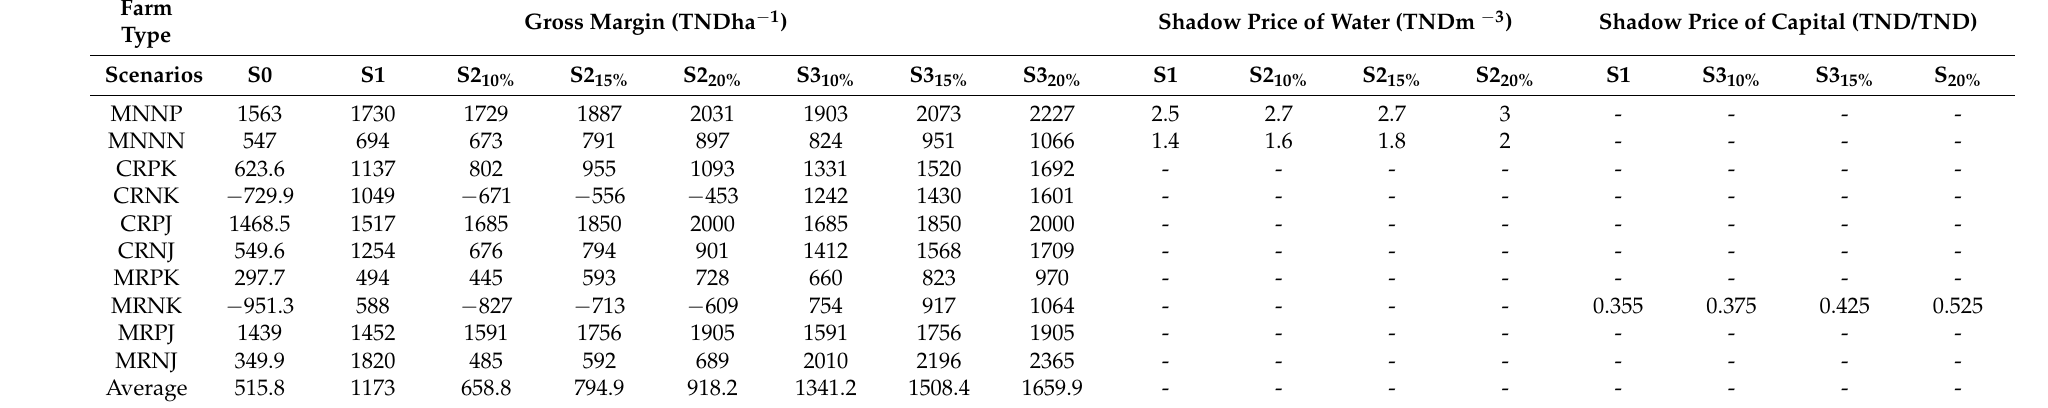
Table 8. Variation of DW gross margin, shadow price of water, and shadow price of capital by farm type and